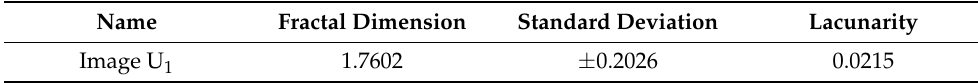
Table 1. Calculation of fractal parameters for picture U 1